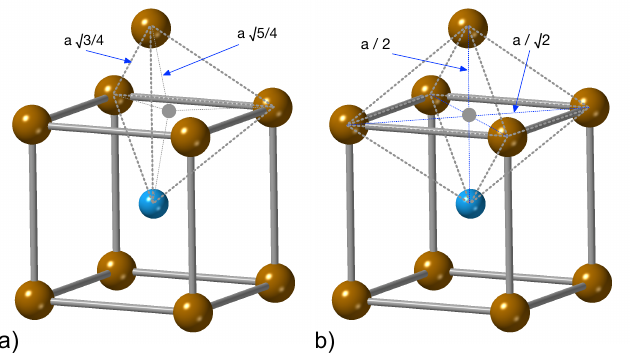
Figure 2. A schematic visualization of selected tetrahedral ( a ) and octahedral ( b ) interstitial sites (shaded small circles) in the D0 3 structure of Fe 3